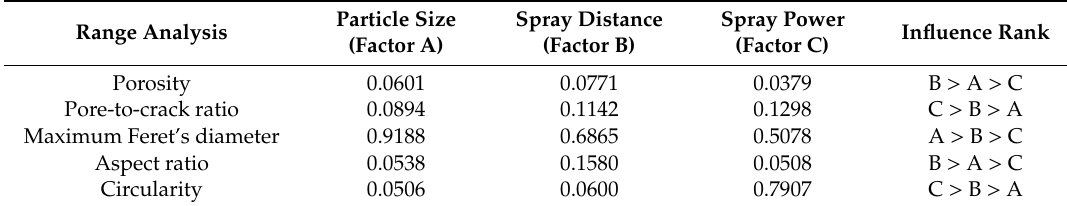
Table 4. Range analysis of three factors at each